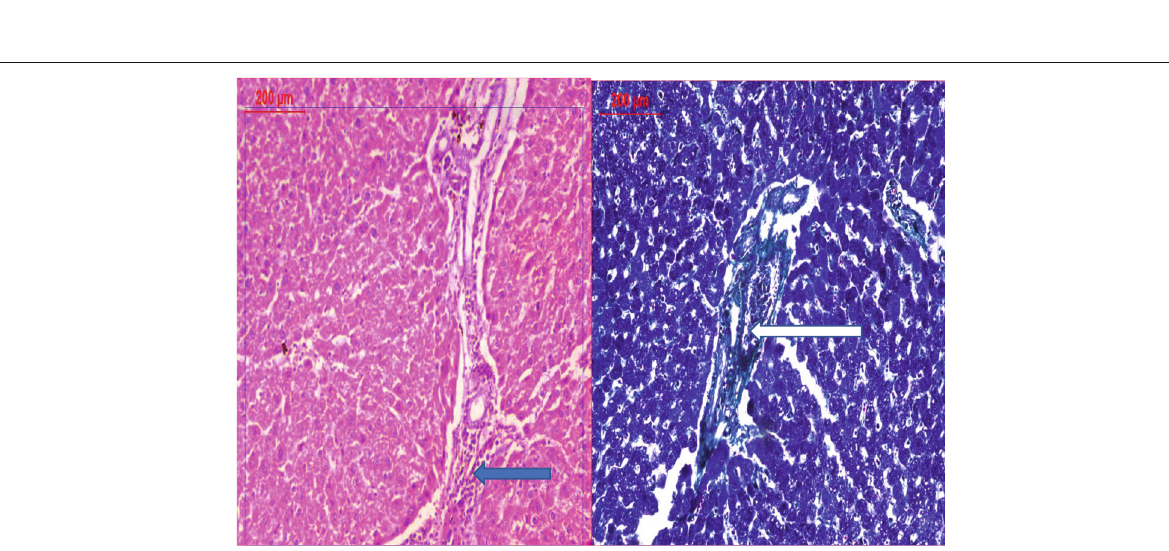
Fig. 6 Photomicrograph for the treated group: showing liver tissue with minimal portal fibrosis and mild inflammatory response (blue arrows), demonstrated by Masson trichrome stain (white arrow) (× 200, ×